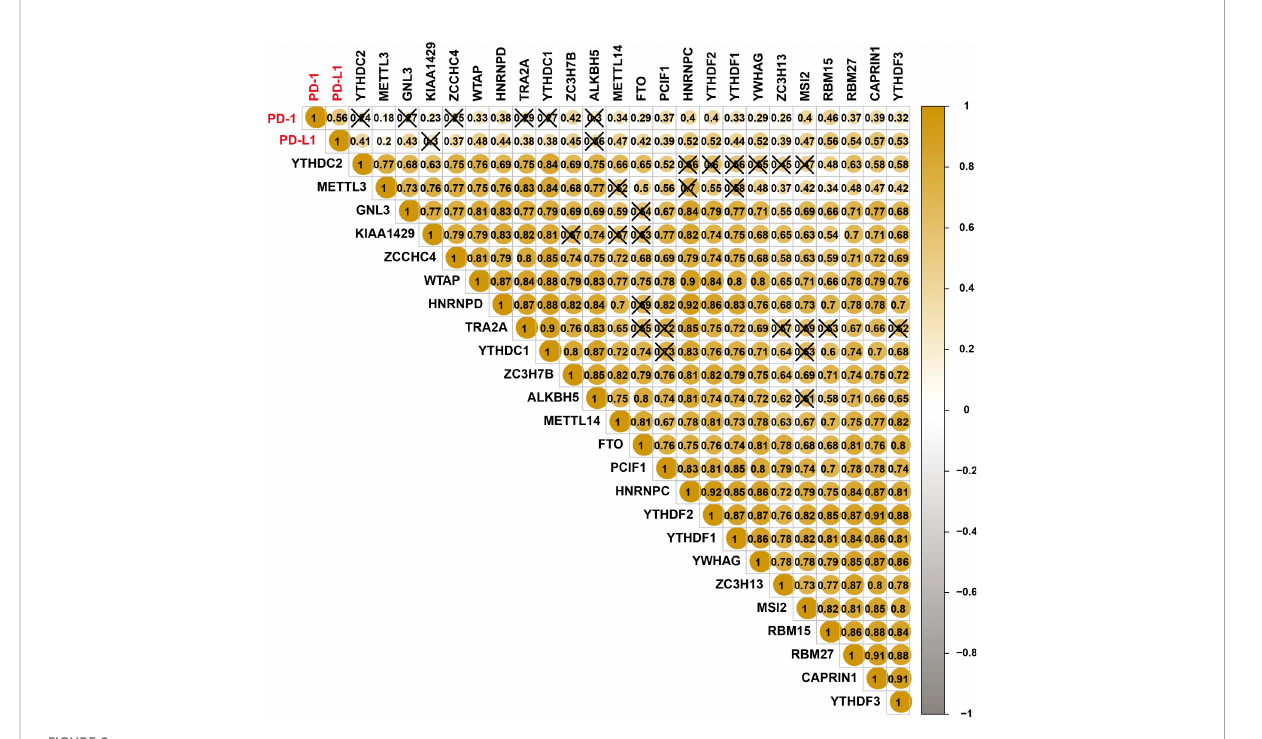
FIGURE 2 Correlations among PD-L1, PD1, and m6A RNA methylation